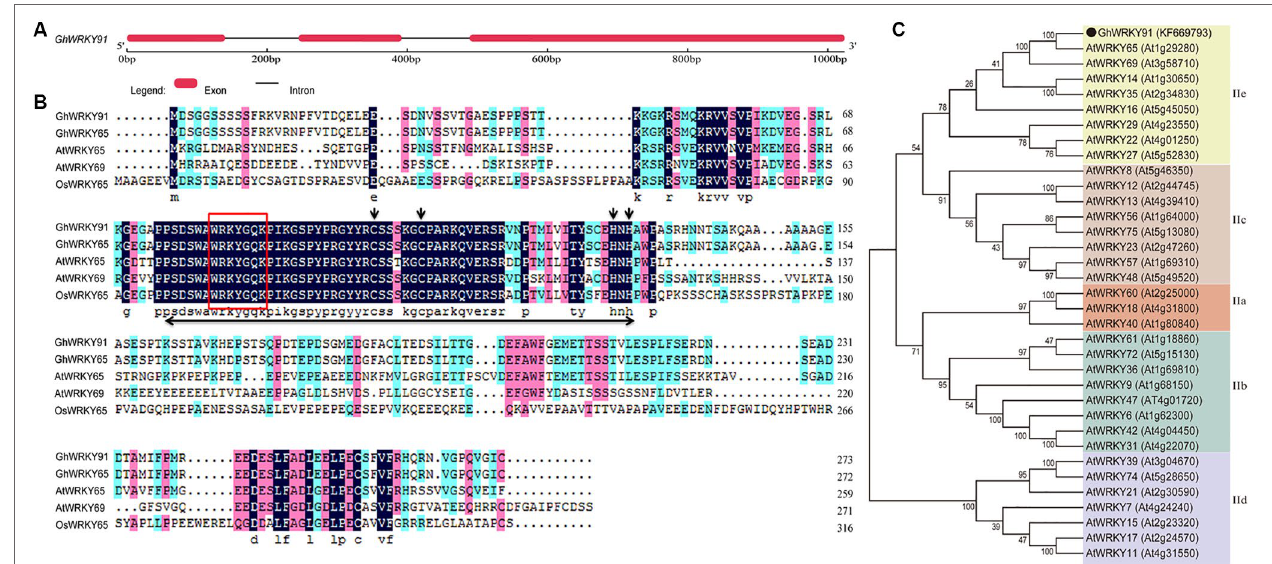
FIGURe 1 | Sequence and phylogenetic analyses of GhWRKY91. (a) Exon-intron structure of the GhWRKY91 gene. The thick red line represents an exon, and the black line represents an intron. (B) Sequence alignment of the GhWRKY91 protein with the closely related proteins GhWRKY65 (Gh_D10G0329.1), AtWRKY65 (AT1G29280.1), AtWRKY69 (AT3G58710.1), and OsWRKY65 (XP_015647591.1). The WRKY domain is indicated by a double-headed arrow. The highly conserved core sequence WRKYGQK in the WRKY domain is represented by a red box. The C and H residues in the zinc finger motif are indicated by downward arrows. (C) Phylogenetic relationship of the GhWRKY91 protein with other group II WRKY proteins from Arabidopsis . GhWRKY91 is indicated by the black dot. The abbreviations before the gene names are as follows: Gh, Gossypium hirsutum ; At, Arabidopsis thaliana ; and Os, Oryza sativa .